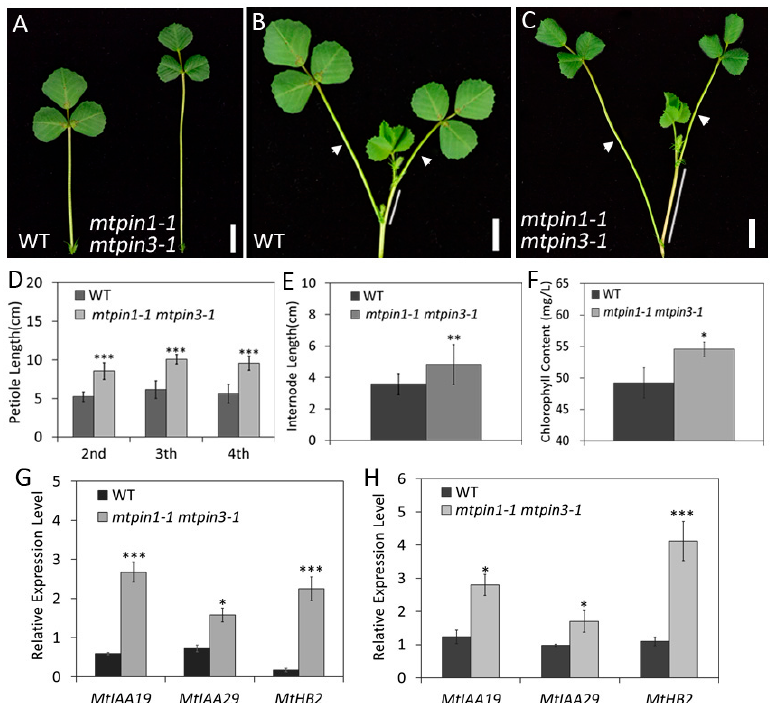
Figure 6. The plants of mtpin1 mtpin3 exhibit the constitutive shadeavoidance responses. ( A ) Mature compound leaf of 60-day-old wild-type (left) and mtpin1-1 mtpin3-1 (right). ( B , C ) A dissected